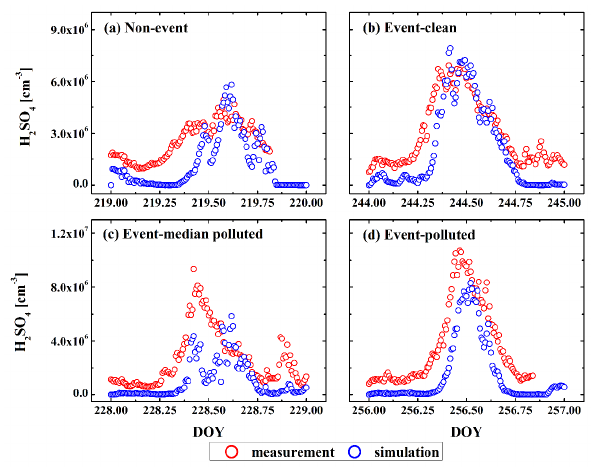
Fig. 1. Measured (red) and modelled (blue) sulfuric acid concen- Figure 1. Measured (red) and modelled (blue) sulfuric acid concentrations for four selected days in diverse 853 trations for four selected days in diverse pollution conditions. (a) pollution condition. (a) Non-event day, (b) ~ (d) NPF event days. The x-axis is presented by DOY (day of year). 854 Non-event day, (b, d) NPF event days. The x axis is presented by DOY (day of